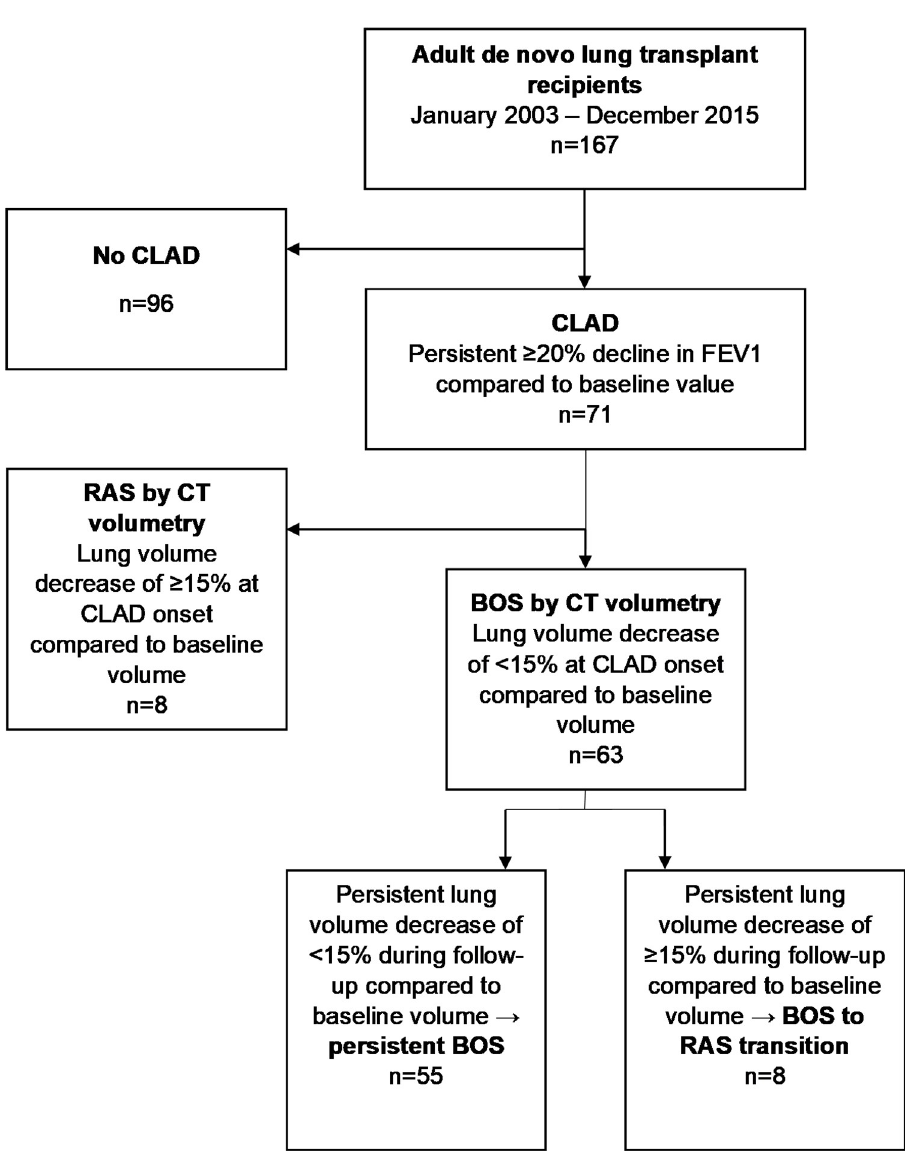
Fig 1. Flow chart of patient classification during study. BOS: Bronchiolitis obliterans syndrome; CLAD: Chronic lung allograft dysfunction; FEV1: Forced expiratory volume in one second; FVC: Forced vital capacity; RAS: Restrictive allograft